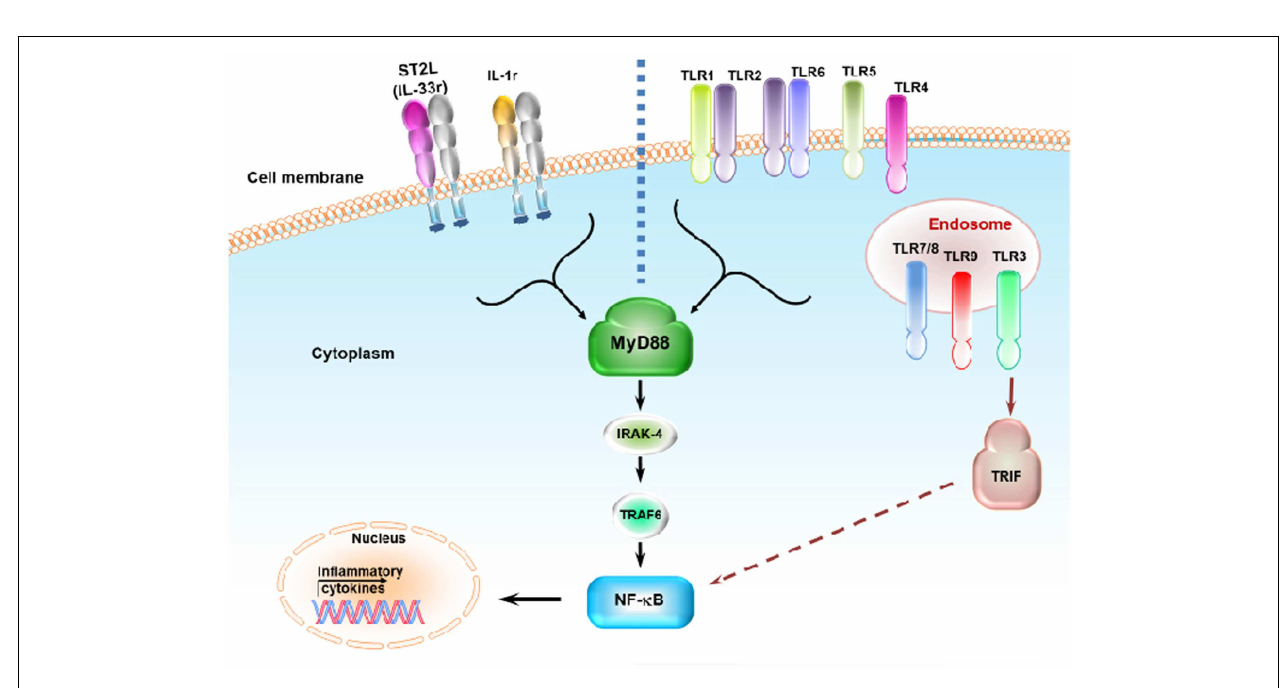
expect forTLR3, which signals through theTRIF pathway.TLR4 can signal through both MyD88 andTRIF.TLR3,TLR7/TLR8, andTLR9 are expressed in the endosome while otherTLRs are expressed on the cell surface.TLR1 andTLR6 recognize their ligand withTLR2 heterodimers.